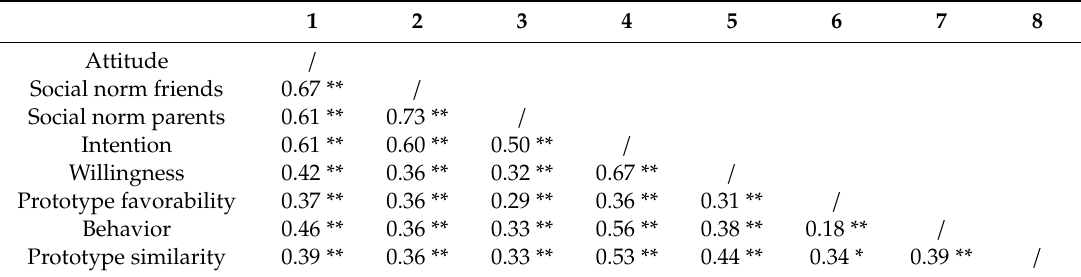
Table 2. Correlations between the research